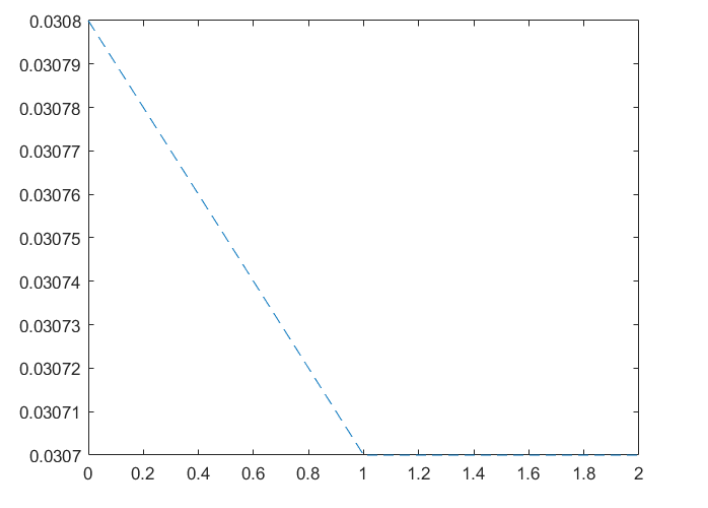
Figure 1. Interpolated graph for t =